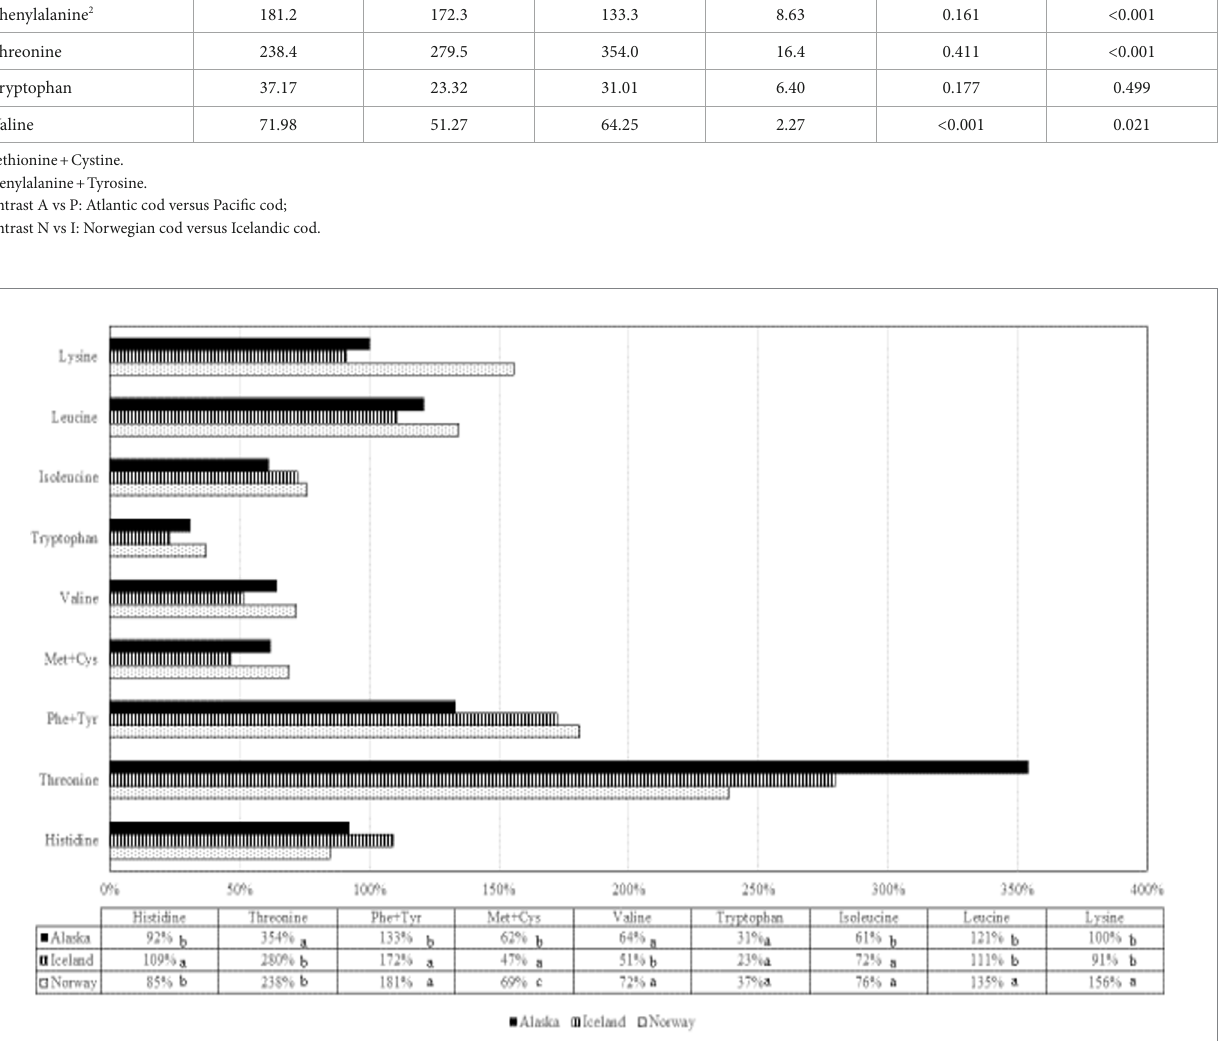
FIGURE 1 Amino acid score (AAS) for adults according to standards reported by the FAO/WHO for